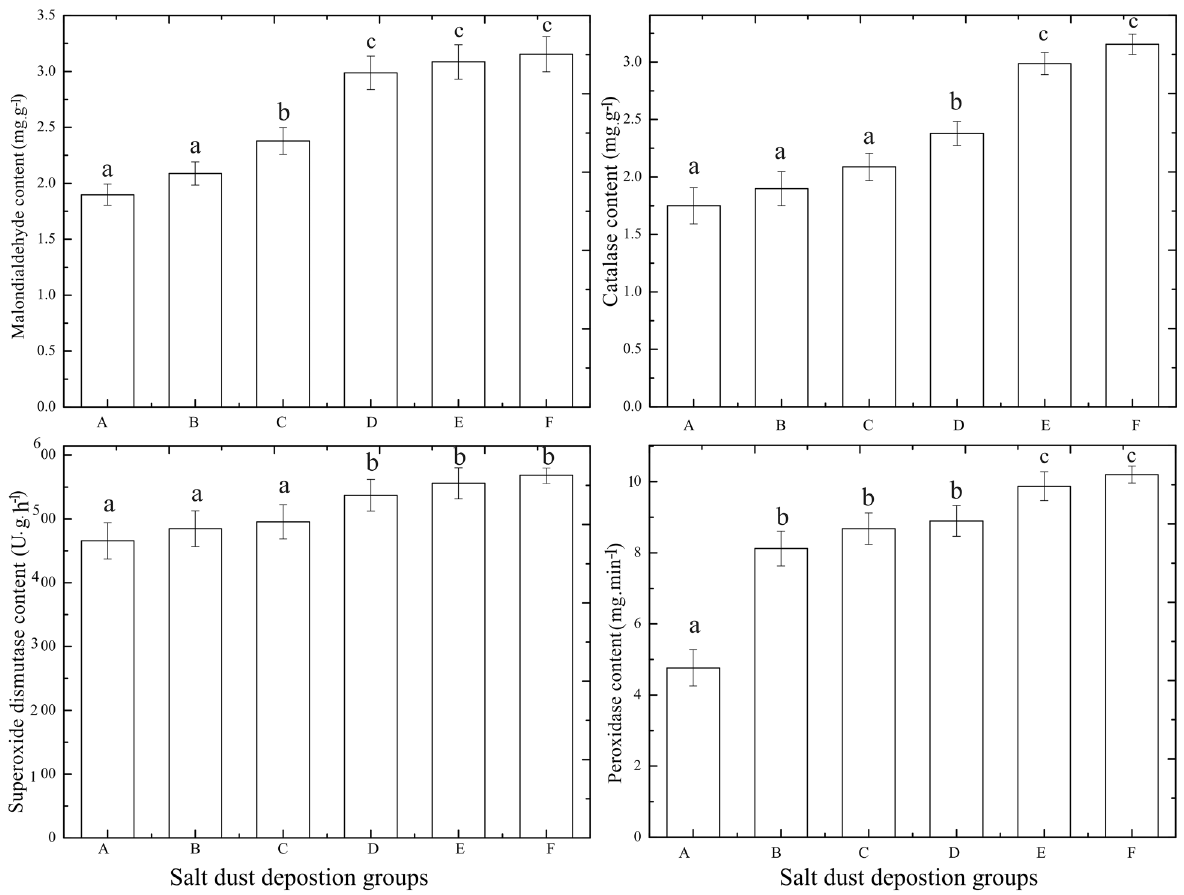
Fig 12. Changes in malondialdehyde (MDA) and antioxidant enzyme activity in the cotton leaves.